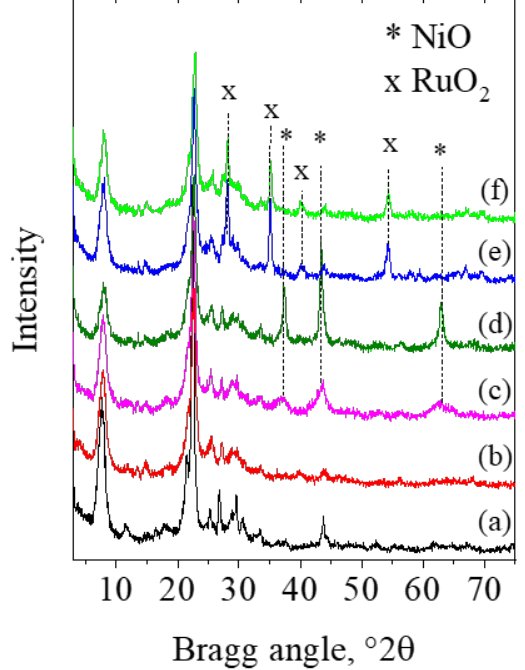
Figure 1. X-ray powder diffraction patterns of the studied catalysts: ( a ) initial zeolite Beta, ( b ) 1Pt/HB, ( c ) 10Ni/HB, ( d ) 10Ni1Pt/HB, ( e ) 5Ru/HB, ( f ) 5Ru1Pt/HB. Table 1. Textural and other physico-chemical properties of the obtained catalysts.